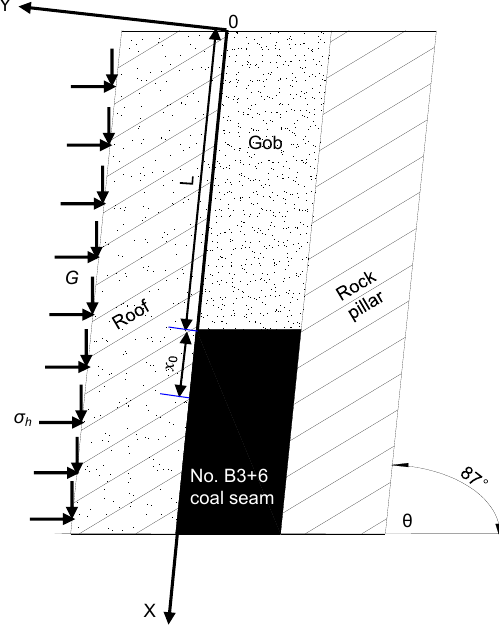
Figure 5. Physical model of the “steeply inclined suspended roof structure”.